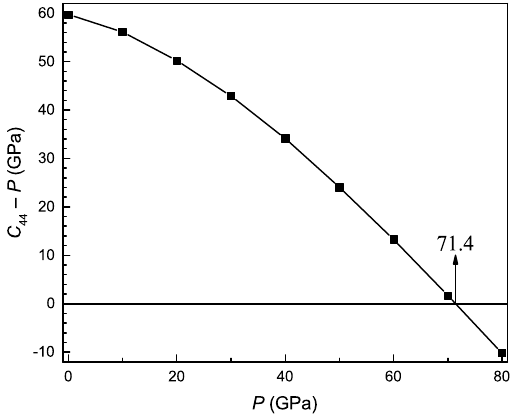
Figure 3. The constant C 44 − P as a function of pressure for Ti 3 Al